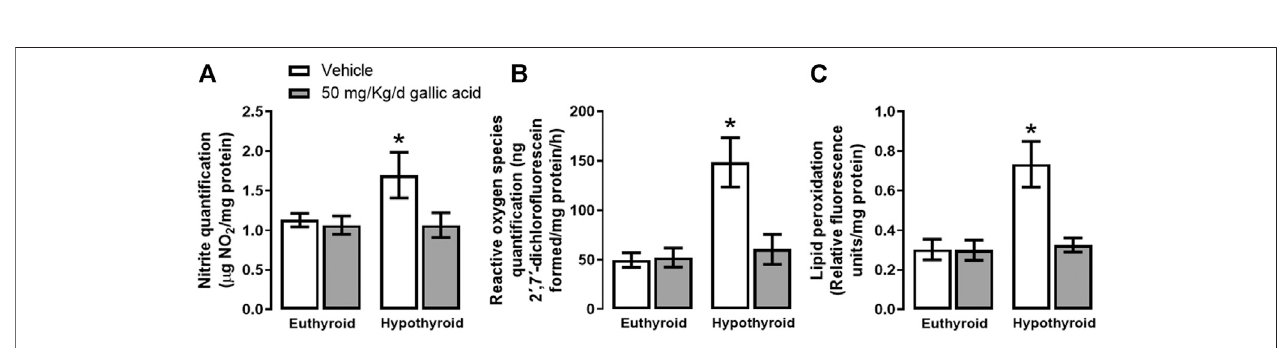
FIGURE 2 | Effect of gallic acid on hypothyroidism-induced oxidative stress in the hippocampus of adult rats. The oxidative stress markers evaluated were nitrite and ROS quanti fi cations (panels A and B) and lipid peroxidation (panel C) . Values represent the mean ± SEM. (*) p < 0.05 vs. Euthyroid + vehicle group.